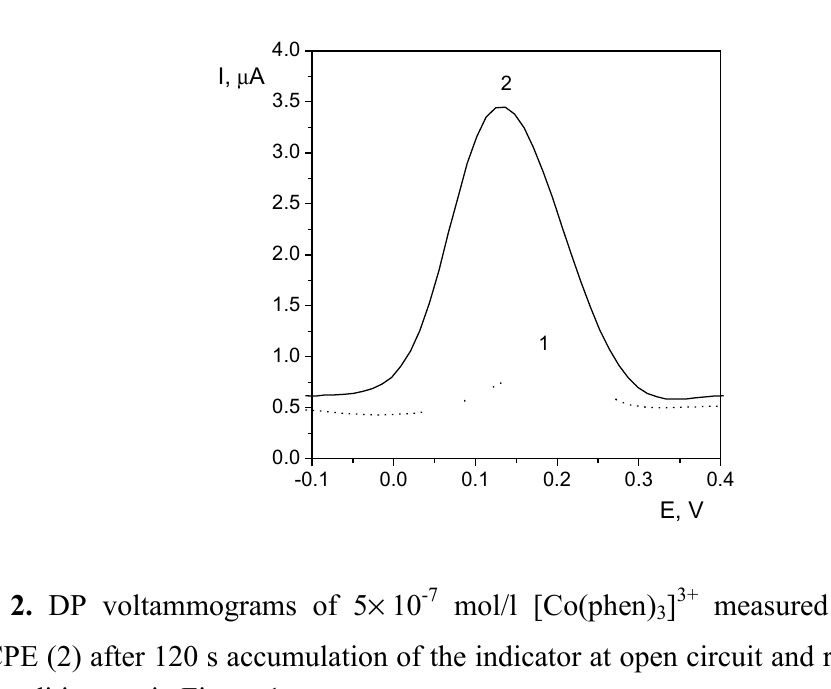
] 3+ measured at CPE (1) and 3